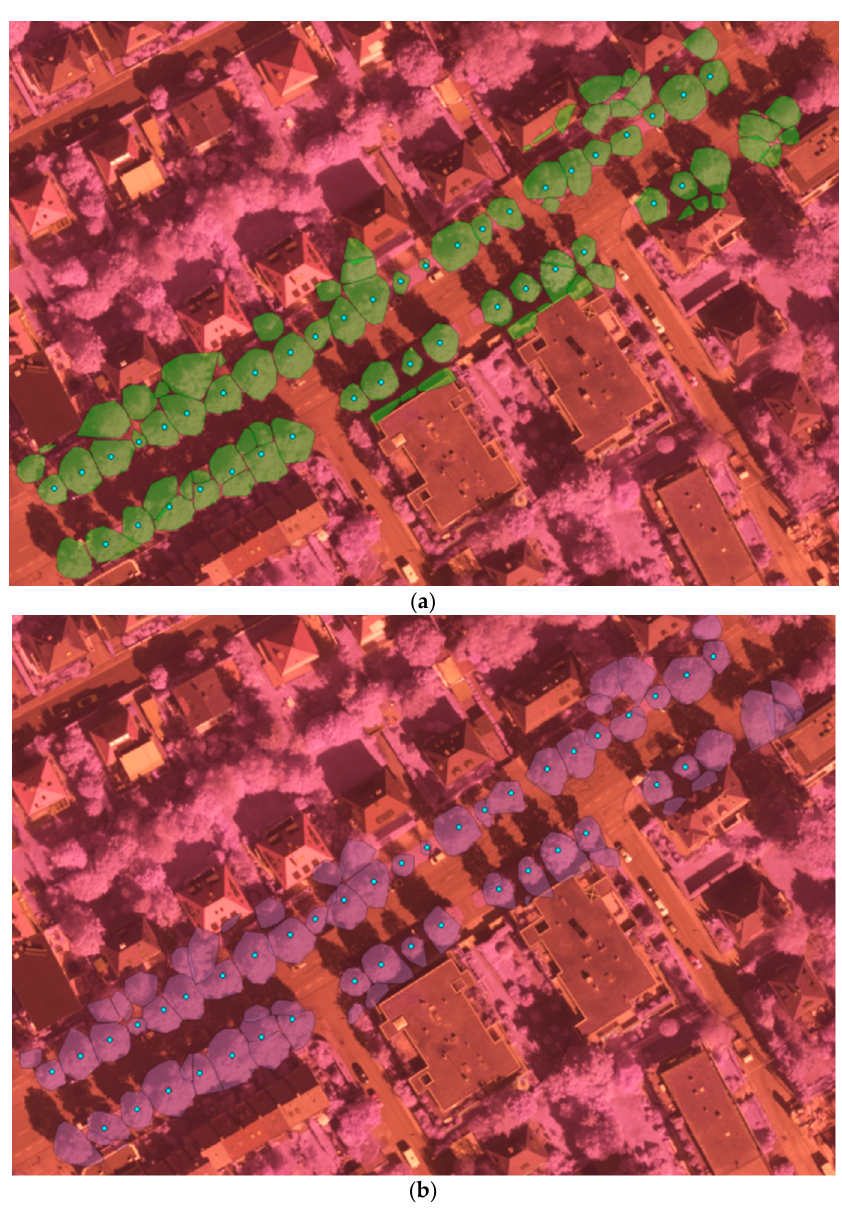
Figure 5. Single tree detection results of ( a ) Seybothstr ALS data and ( b ) Seybothstr MLS data.